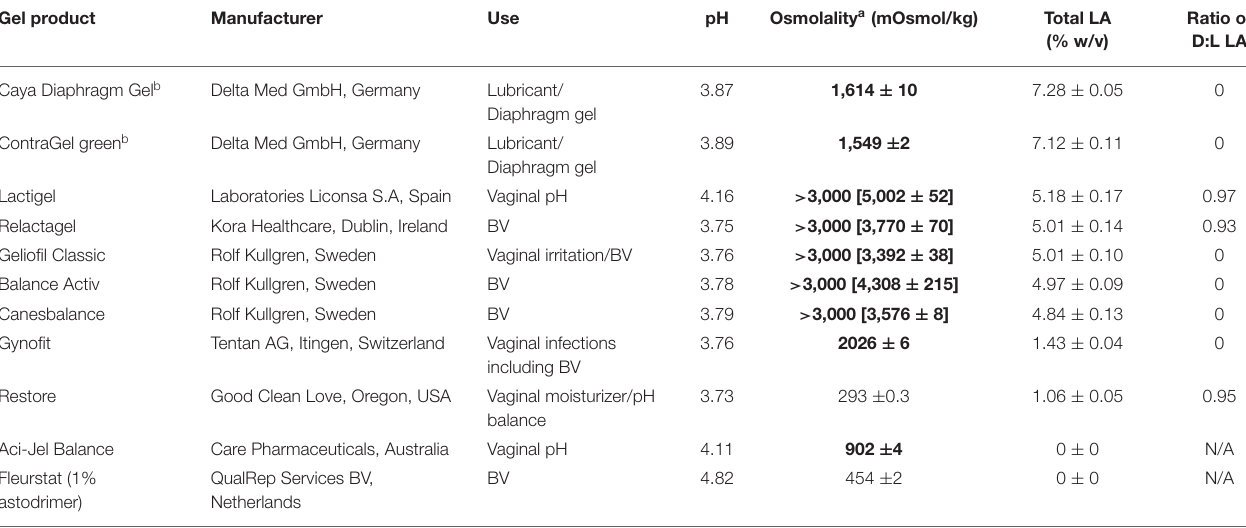
TABLE 1 | Physicochemical properties of over-the-counter (OTC) gels. Gel